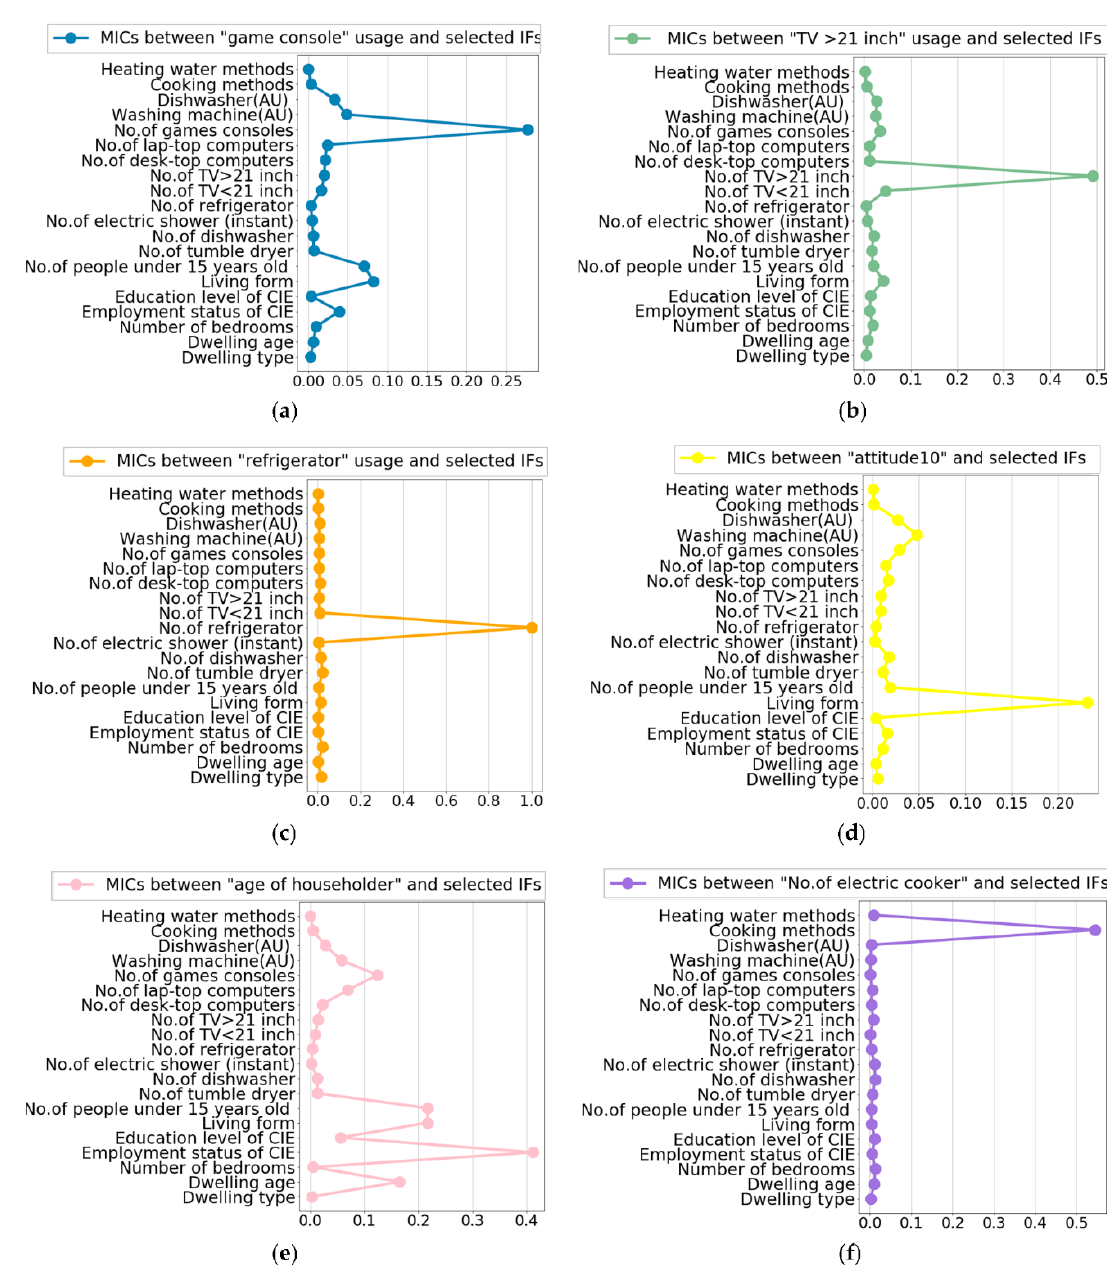
Figure 8. The maximal information coefficients (MICs) between redundant IFs (i.e., “game console” usage, “TV > 21 inch” usage, “refrigerator” usage, “attitude10”, “age of householder” and “No. of electric cooker”) and selected IFs (listed in the left part of each aa) is shown in the above figures. For example, in Figure ( a ), each point corresponds to a certain value of the abscissa and this value represents MIC (ranges from 0 to 1) between “game console” usage and the IF to which that point corresponds in the left part of this figure. ( a ) MICs between “game console” usage and selected IFs; ( b ) MICs between “TV > 21 inch” usage and selected IFs; ( c ) MICs between “refrigerator” usage and selected IFs; ( d ) MICs between “attitude10” and selected IFs; ( e ) MICs between “age of householder” and selected IFs; ( f ) MICs between “No. of electric cooker” and selected IFs.